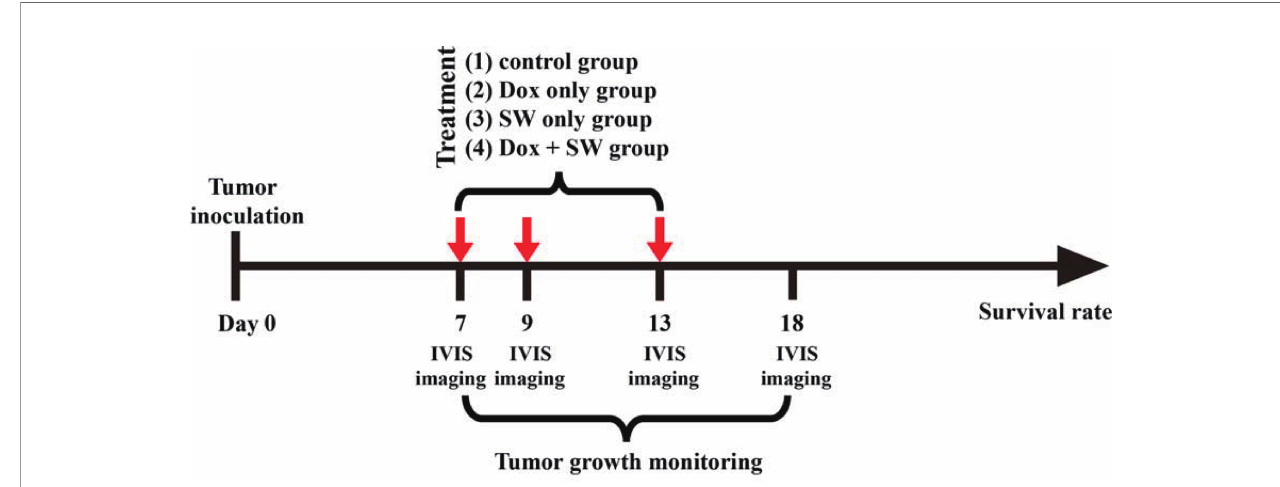
FIGURE 1 | Experimental timeline for the treatment. SW, shockwave; Dox, doxorubicin; in-vivo imaging